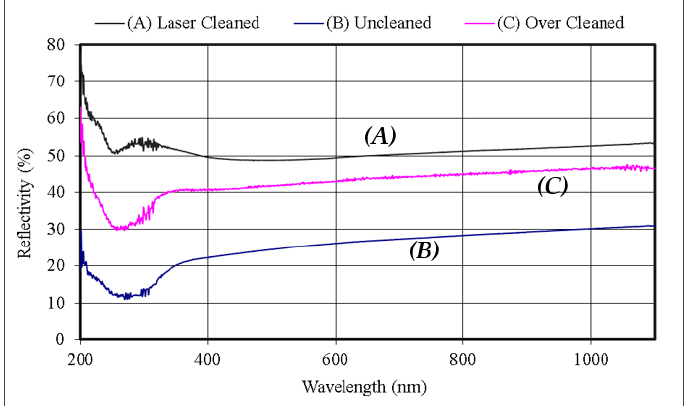
Figure 4. Reflectivity spectrum of a typical workpiece used for laser cleaning.